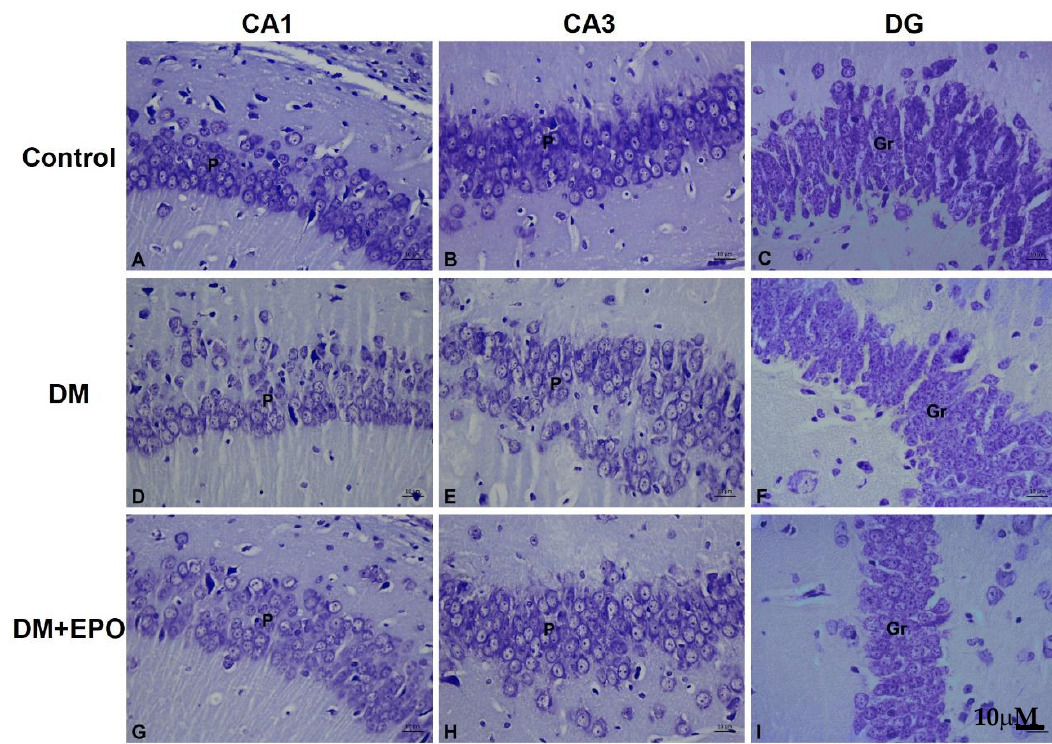
Figure 3. Cresyl violet staining of the CA1, CA3, and dentate gyrus (DG) regions of the hippocampus from control, diabetic (DM) and erythropoietin-treated diabetic (DM+EPO) mice (images A – I ). Magnification × 400. Across all three regions in control mice, was observed Nissl granular constituents of the cytoplasm of cells which appeared dark violet, the nuclei of cells also appeared dark violet. P: pyramidal cells, Gr: granule cells. The rest of cytoplasm appeared lightly stained. In DM mice, Nissl granular components of the cytoplasm of cells were decreased compared to controls; granules in the cytoplasm of cells showed the cells paler in staining with less ribosomes inside. This was observed in all three regions. In DM+EPO mice, Nissl staining of the cells showing improvement in the Nissl granules and darker staining with more ribosomes inside compared to controls. This was in all three regions.